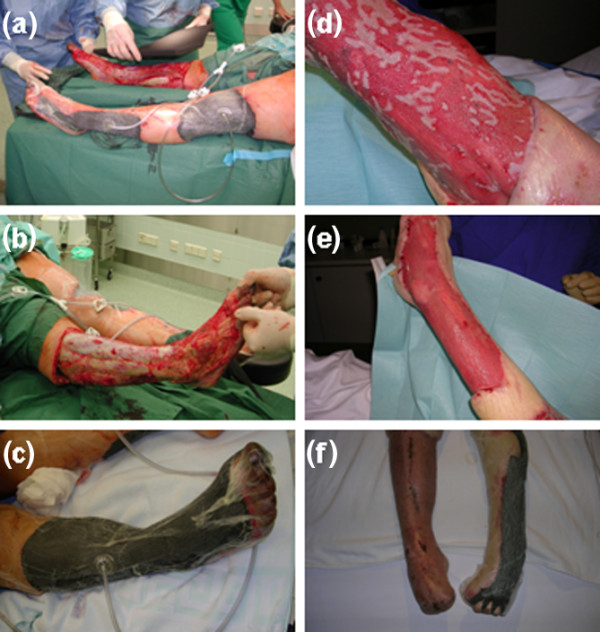
Wound management from primary surgery to delayed secondary closure. (a-c) Large-scale tissue damage at both lower extremities and vacuum sealing. (d,e) Wound site fills with granulation tissue. (f) Skin grafting at right lower extremity. Note that toe amputations had to be performed at right lower extremity due to severe septic microembolism.